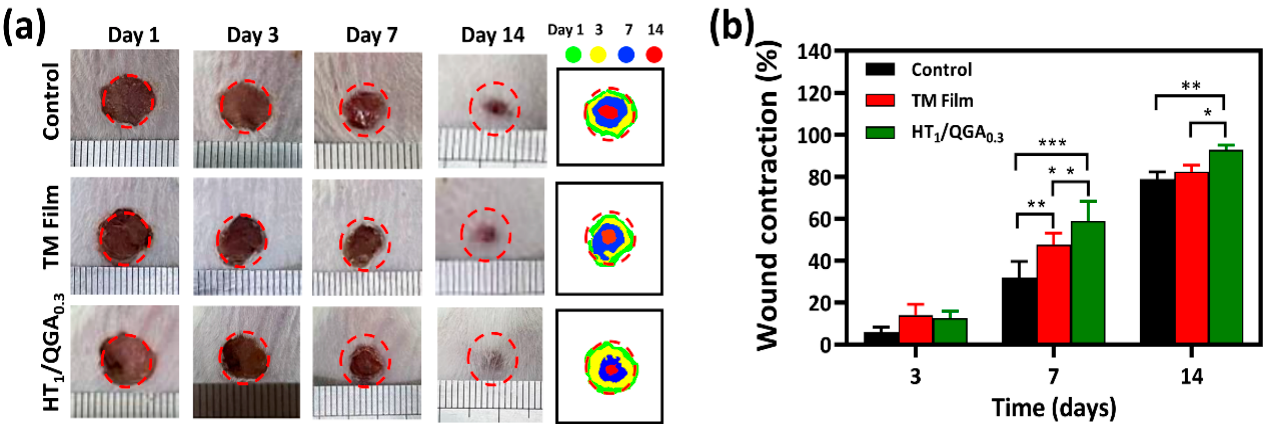
Figure 8. ( a ) Photographs and schematic diagram of wound area on 1st, 3rd, 7th, and 14th day of Control, TM film and HT 1 /QGA 0.3 hydrogel group; ( b ) Wound contraction of each group. * p < 0.05, ** p < 0.01, *** p < 0.001, mean ± SD, n = 3.